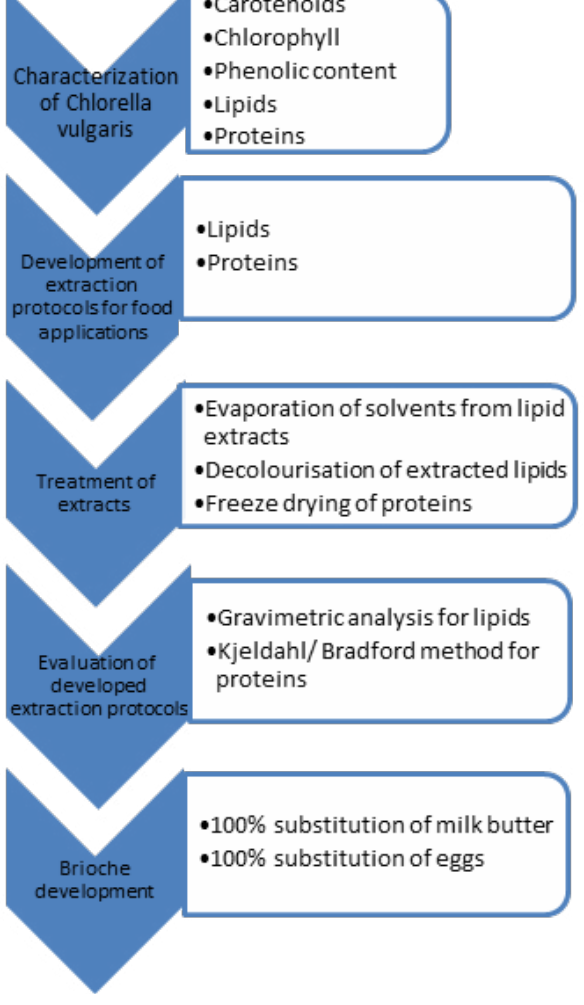
Figure 2: Shematic description of the methodology Characterization of raw material. The Jeffrey protocol was used for the determination of total carotenoids and chlorophyll (Jeffrey et al. 1997). Consequently, 50 mg of dry Chlorella biomass were dissolved in 5 ml acetone 90%. The solution was vortexed and left in a freezer for 24 hr at −18°C. The solution was then vortexed until it reached room temperature. Finally, the solution was centrifuged for 10 min in 3000 rpm. The supernatant measured at 480, 510, 630, 647 and 664, with spectrophotometer A Bel Photonics uv-m51 (Piracicaba, Brasil). For blank samples, acetone 90% was used. For the determination of chlorophyll,